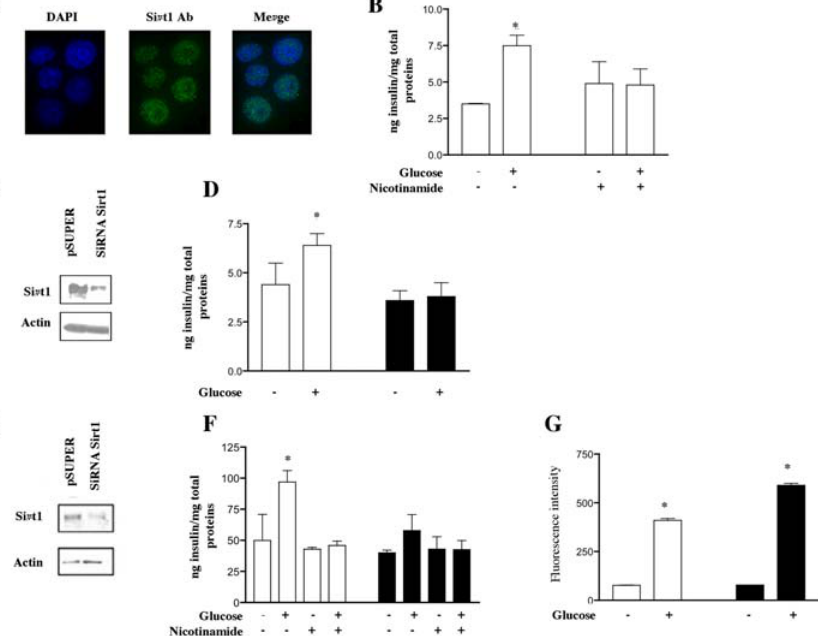
Figure 3. Sirt1 Is a Positive Regulator of Insulin Secretion in INS-1 and MIN6 Cells (A) Immunofluorescence in INS-1 cells using Sirt1 antibody (green) and DAPI staining (blue). Nuclear localization of Sirt1 is evident. (B) Induction of insulin secretion in INS-1 cells with 16.7 mM glucose ( þ ) compared with 4 mM glucose control ( (cid:1) ). The left side shows no nicotinamide and the right side shows treatment with 10 mM nicotinamide for 48 h prior to induction ( n ¼ 3 experiments done in triplicate, * p , 0.05 in the no nicotinamide experiment, ANOVA). (C) Western blot of Sirt1 in INS-1 cells with knockdown levels of the protein (SiRNA Sirt1) compared with control cells (pSUPER). (D) INS-1 cells infected with the pSUPERretro SiRNA-GFP control (open bars) or pSUPER retro SiRNA-Sirt1 knockdown cells (black bars) were induced for insulin secretion as in (B) ( n ¼ 3 experiments done in triplicate, * p , 0.008 in the control experiment, ANOVA). (E) Western blot of Sirt1 in MIN6 cells with knockdown levels of the protein (SiRNA Sirt1) compared with control cells (pSUPER). (F) Glucose induction (20 mM versus 4 mM) of insulin secretion in MIN6 cells with the pSUPER control vector (open bars) or the SiRNA Sirt1 vector (black bars) in the absence or presence of nicotinamide ( n ¼ 3 experiments done in triplicate* p , 0.05 in the control without nicotinamide, ANOVA). (G) Glucose uptake in INS-1 cells stably transfected with control or SiRNA Sirt1 vectors. 2-NBDG fluorescence was determined by flow cytometry 10 min after addition and expressed as arbitrary units ( n ¼ 2, * p , 0.0005 compared with no